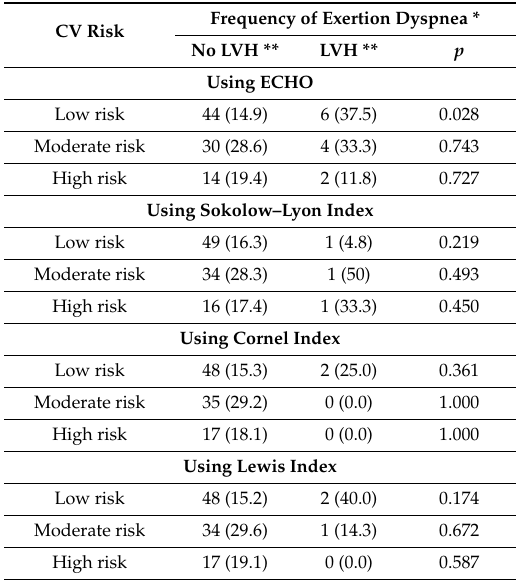
Table 8. The comparison of the frequency of exertion dyspnea between individuals with and without left ventricular hypertrophy in low, moderate, high, and very high cardiovascular risk classes.